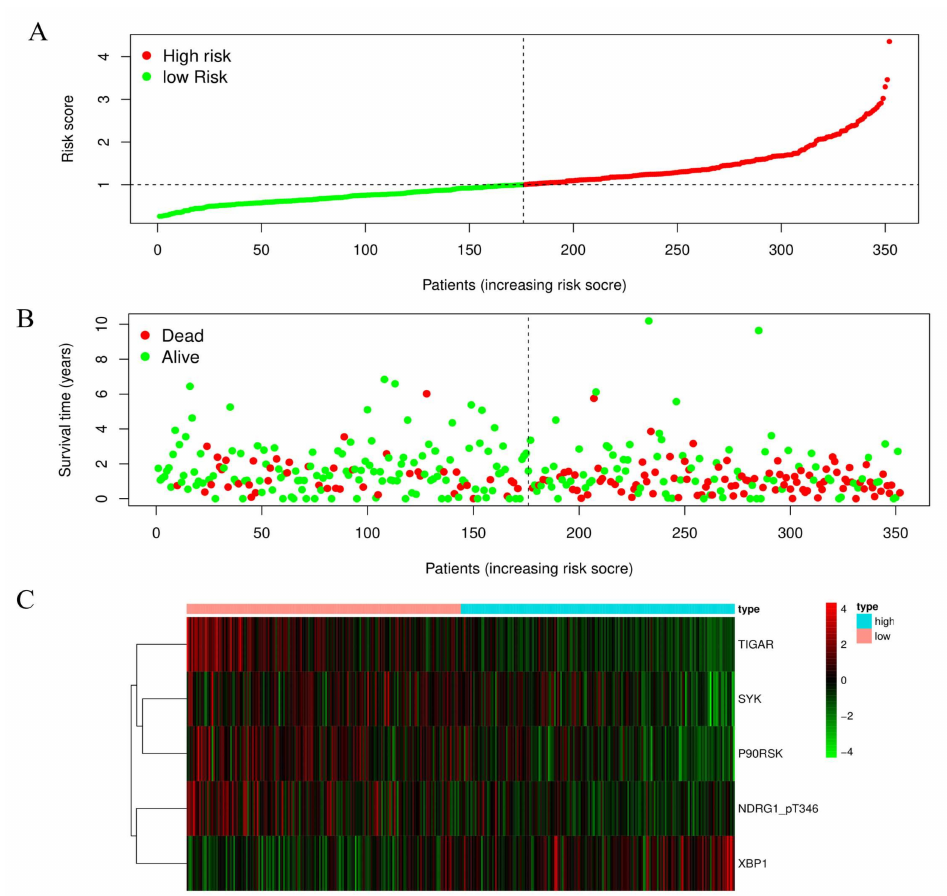
Figure 2. Construction of a protein risk prognostic model in STAD. ( A ) The patients were divided into high-risk and low-risk groups based on the risk scores. The risk scores for all patients were ranked in ascending order and were divided by the threshold (vertical dotted line). The green dots in the left and red dots in the right indicated the low- and high-risk groups respectively. ( B ) The scatter diagram showed the survival time and survival status of each patient in high- and low-risk groups. The red and green dots represented death and alive respectively. The high-risk group had more deaths compared to low-risk group. ( C ) The risk heatmap showed the expression levels of five prognostic-risk model proteins between high-risk and low-risk groups. The dark red and green represented higher expression and lower expression